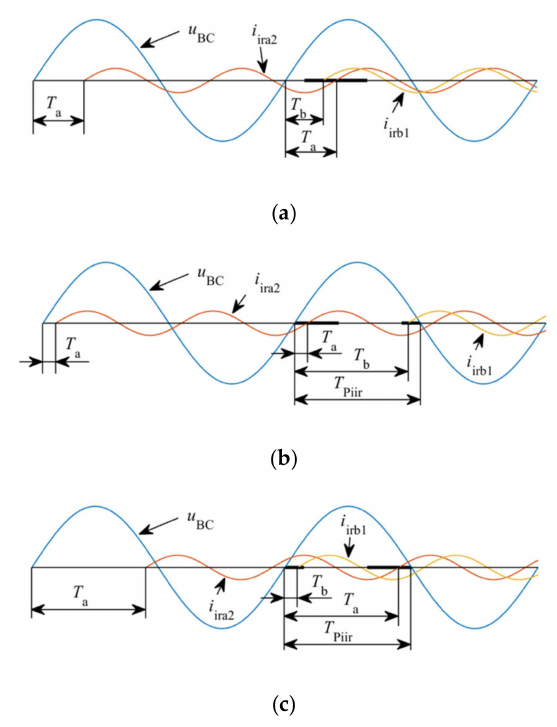
Figure6. Possiblerelationshipbetween T a and T b toachievethementionedphasedi ff erence. ( a ) T int = 0; ( b ) T int = − T Piir ; ( c ) T int = T Piir . The bold lines represent the proper position for the first zero phase